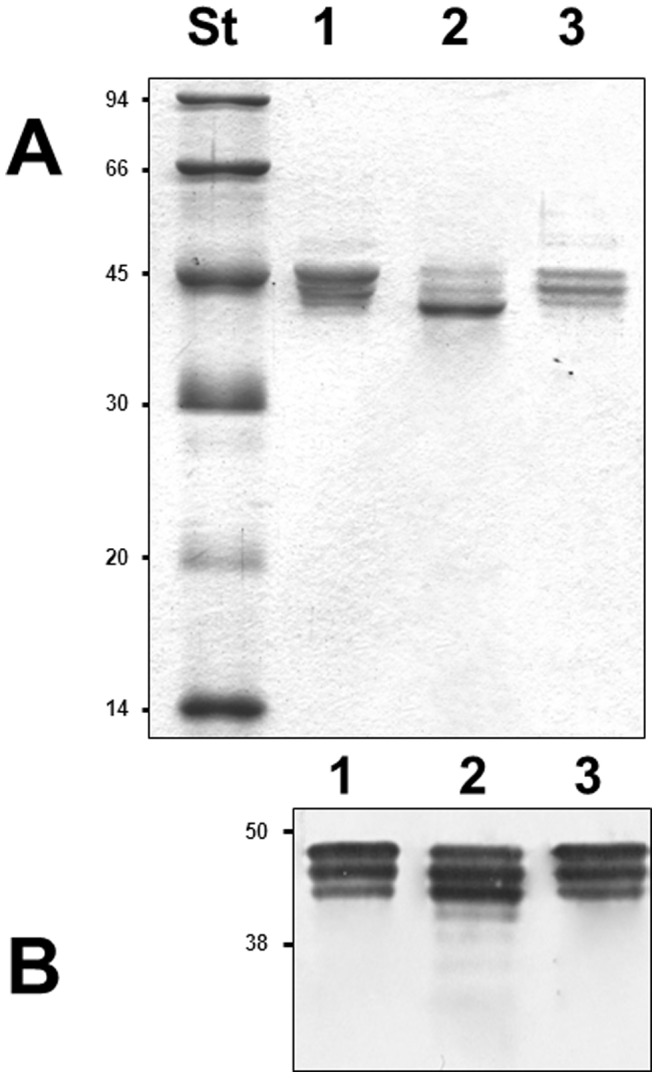
Purified polar flagellins from several A. hydrophila strains obtained according to Materials and Methods.A/SDS-PAGE and B/Western blot using specific antiserum against purified polar flagellins. St, size standard (14, 20, 30, 45, 60, and 94 kDa). 1, A. hydrophila AH-3 (wild type); 2, A. hydrophila AH-3ΔWecP mutant and 3, A. hydrophila AH-3ΔWecP complemented with plasmid pBAD33-WecPAh (18). Figure 2A lane 2 shows a clear reduction in the AH-3ΔWecP mutant polar flagellin MW. In Figure 2B the AH-3ΔWecP mutant polar flagellin shows several minor bands with reduced MW (lane 2) not observed neither in lane 1 (wild type) or lane 3 (complemented mutant).